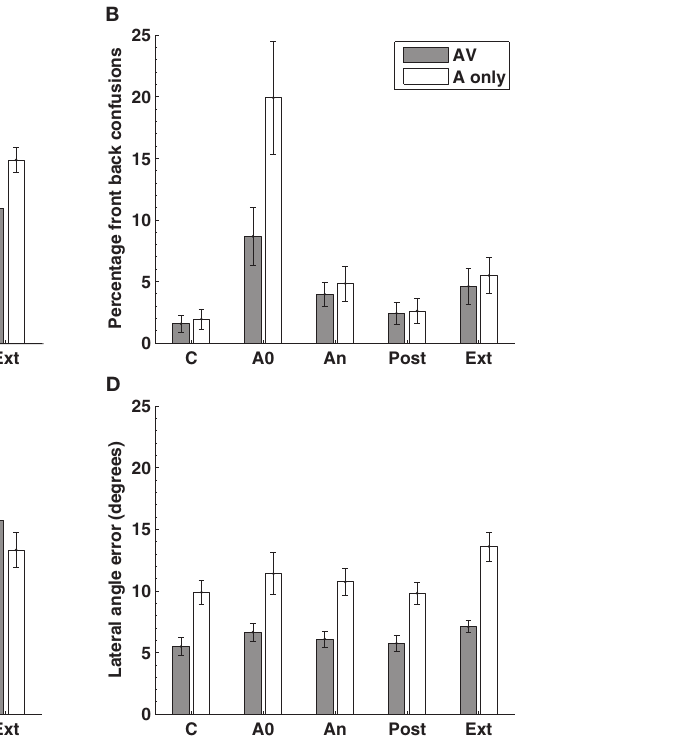
placement of the mold; An, performance at the end of the accommodation period (mean 40.5 days); Post, performance immediately after removing the molds at the end of accommodation; Ext, performance on reinsertion of the molds more than a week after the end of accommodation. The gray bars represent data obtained from the audio-visual region of space ( ± 70 ◦ from the midline) while the open bars represent data from the audio-only region outside these limits. Figure 2 from Carlile and Blackman